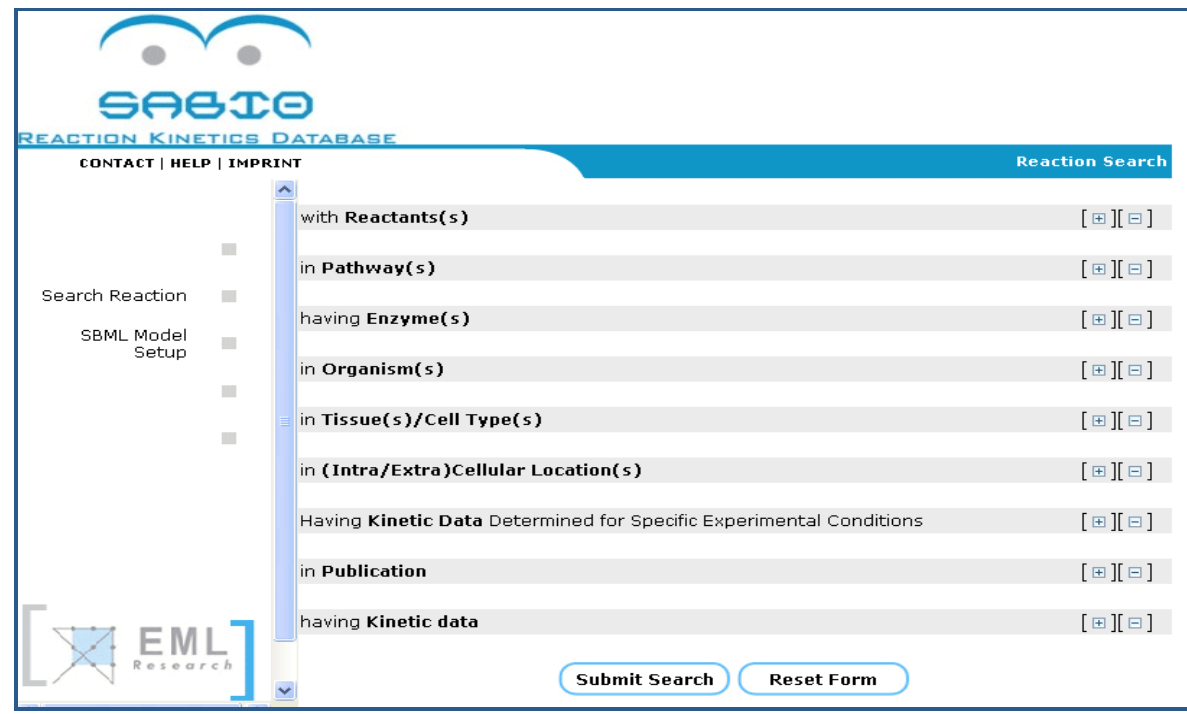
Figure 3. The SABIO-RK user interface allows the search for reactions and their kinetics by combining multiple criteria such as reactants, catalyzing enzymes, organisms,